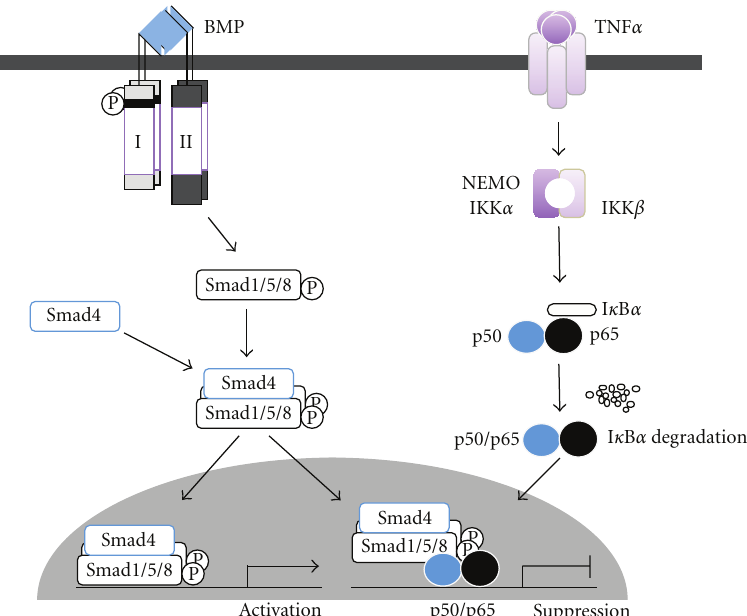
Figure 3: A model of NF- κ B-mediated inhibition of BMP/Smad-mediated DNA binding activity. NF- κ B, particularly the p65 subunit, binds the Smad1/Smad4complex directly or indirectly, and that this binding interferes with the DNA binding of Smad proteins induced by BMP-2.